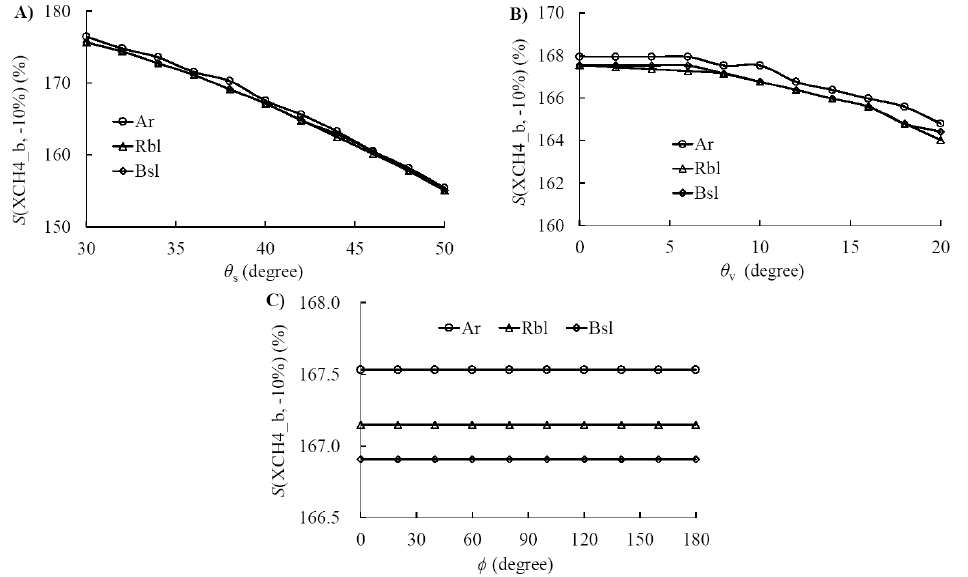
Figure 9. Column retrieval error ( S ( k = 1, α = − 10%)) where k = 1 signifies the plume profile (Figure 3) for ( A ) solar zenith angle (θ s ) when viewing zenith angle (θ v ) and relative sun-senor azimuth angle ( φ ) are equal to 8°, 90° respectively, ( B ) θ v when θ s and φ are equal to 40°, 90° respectively, and ( C ) φ when θ s and θ v are equal to 40°, 8° respectively.